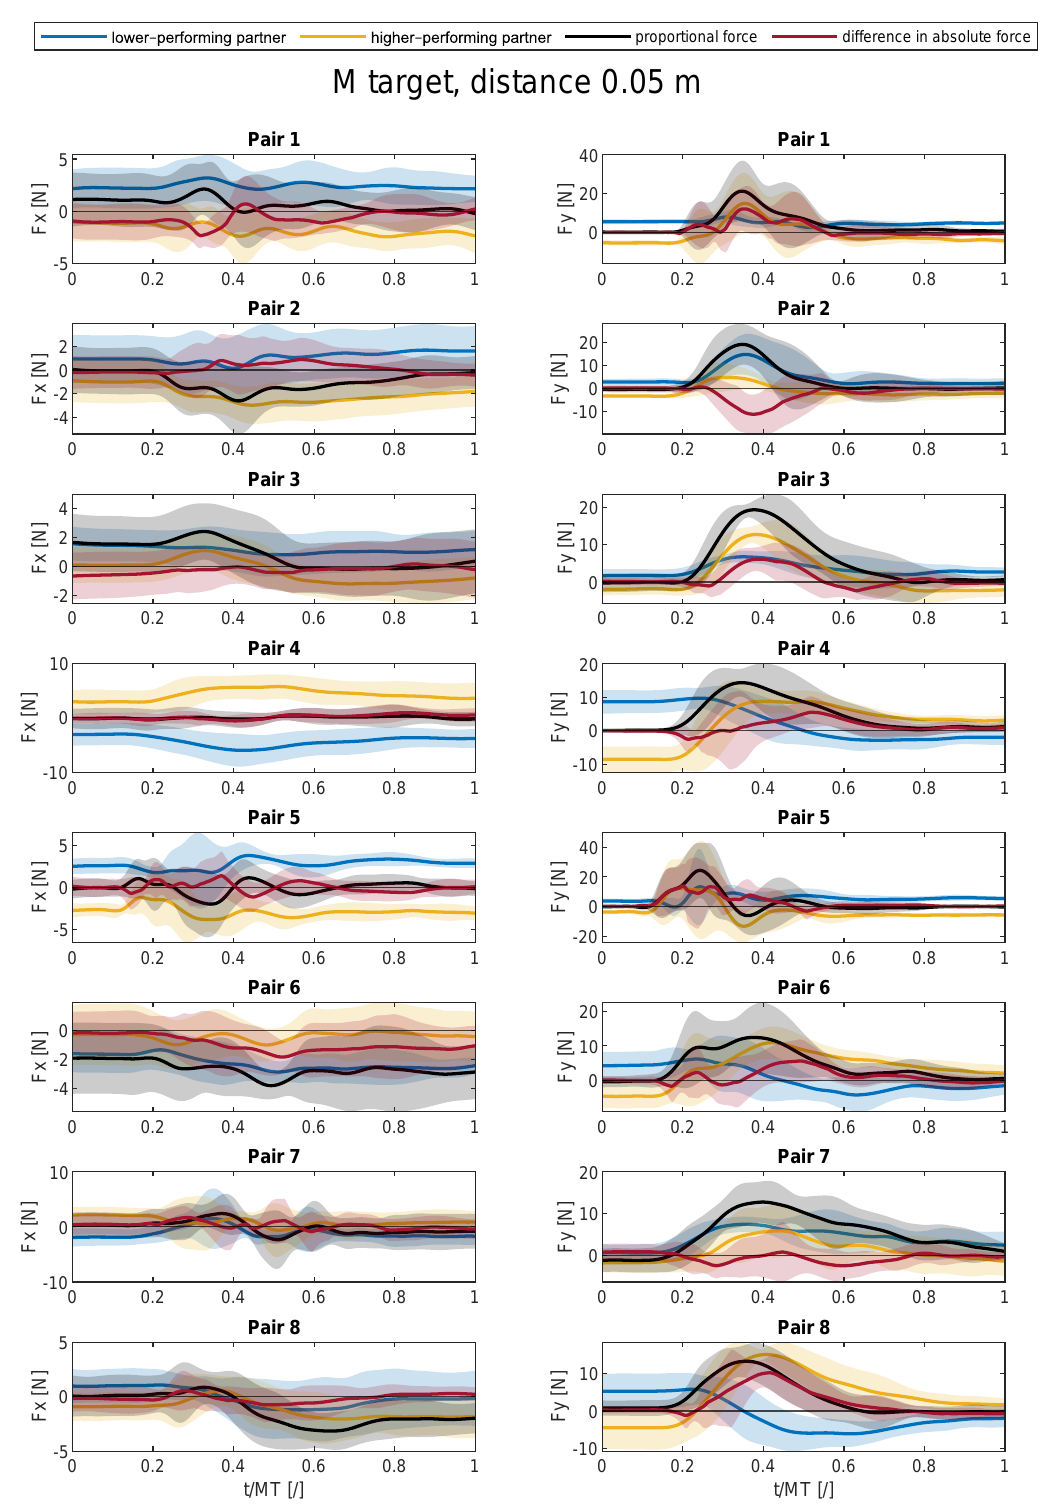
Figure A4. Average force trajectories with standard deviation (shaded area) in x- and y-direction in collaborative task for the medium target at the distance of 0.05